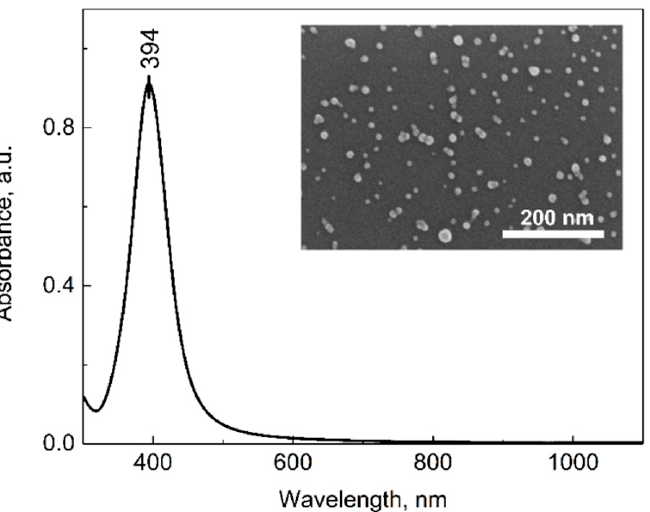
Figure 1. Absorption spectrum of synthesized silver NPs. SEM image of the nanoparticles on Si substrate is presented in the inset. Scale bar represents 200 nm.